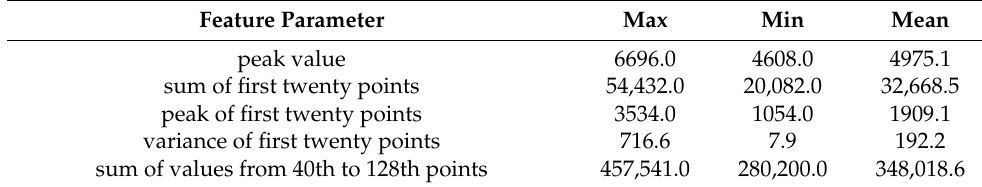
Table 3. Other relevant derived variables of grinding